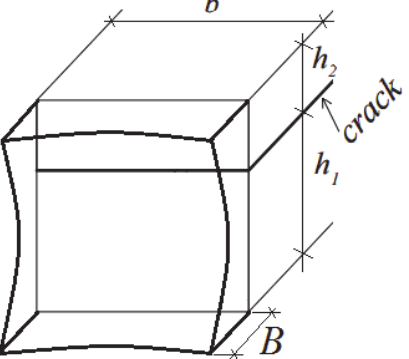
Figure 2: Distribution of the material property, B , in the beam